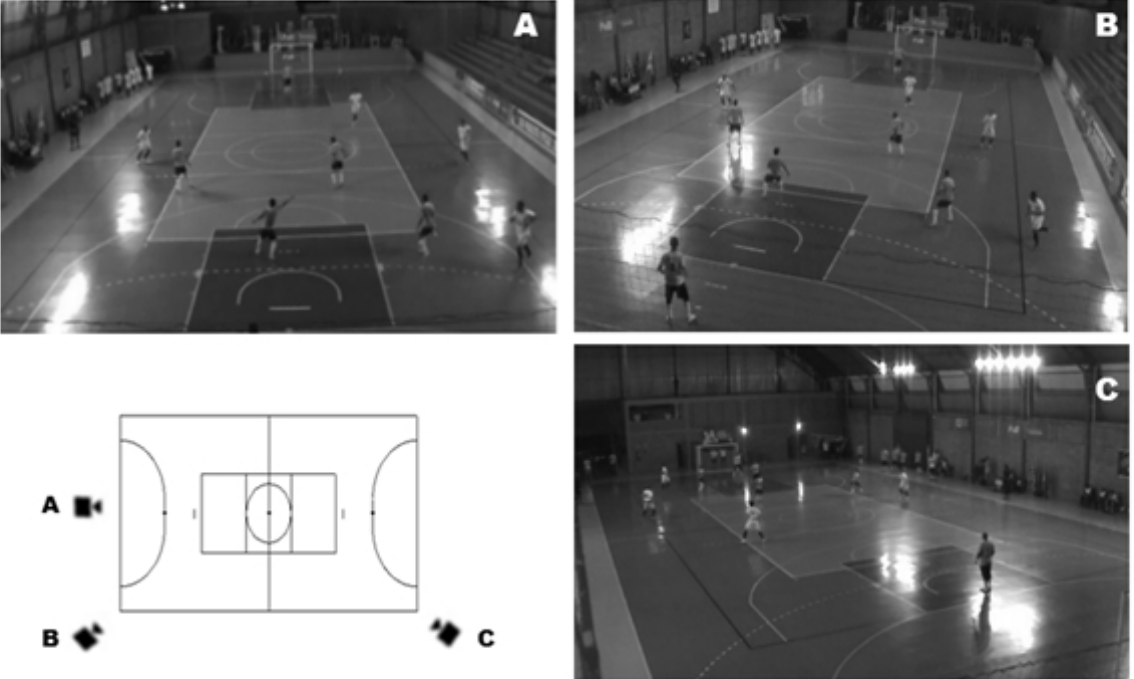
Figure 1. Position of cameras at the highest points in relation to the game court surface for the recording of the events in both